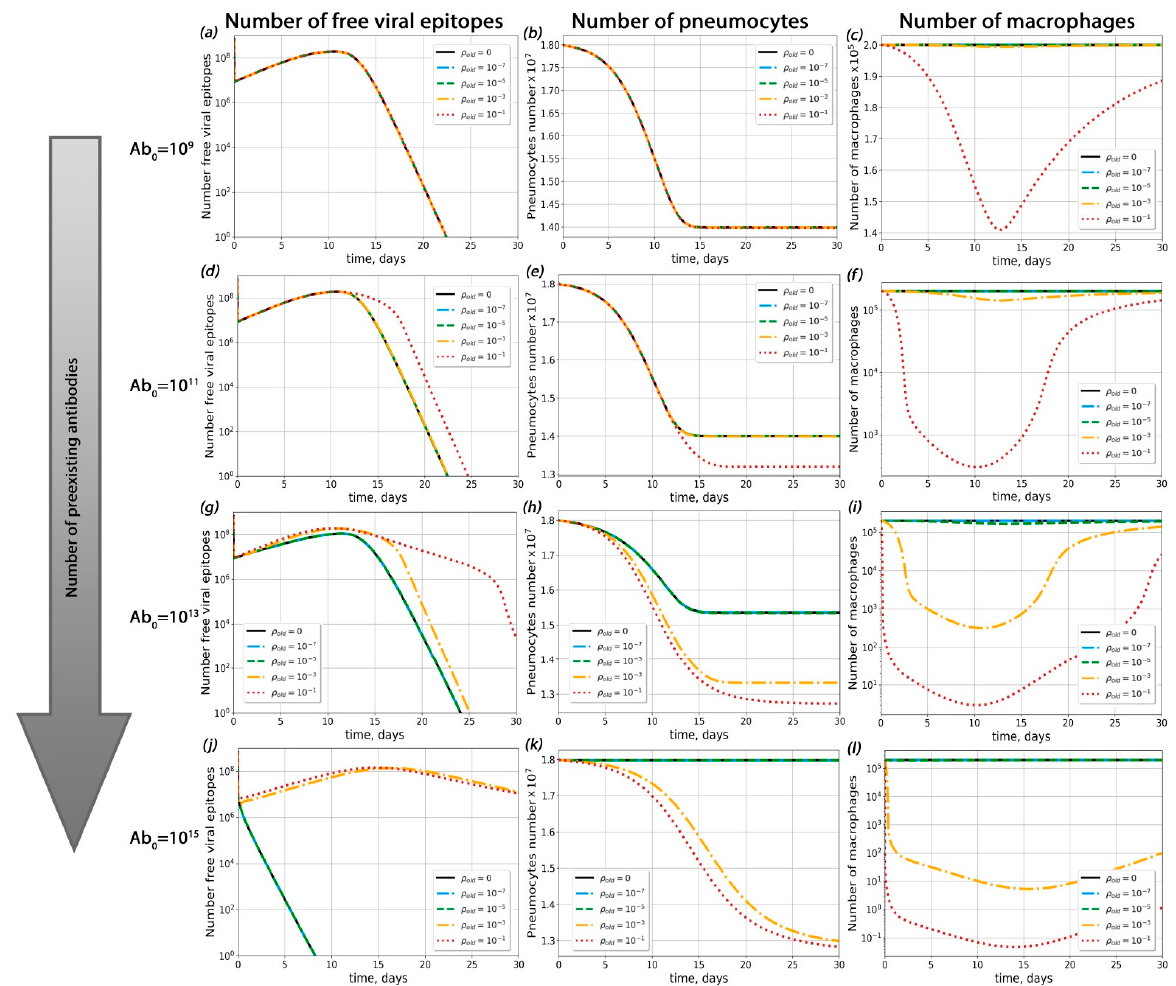
Figure 4. Influence of pre-existing antibodies with different macrophage infection probabilities on possible ADE occurrence. ( a – c ) Viral load dynamics ( a ), pneumocyte number ( b ) and macrophage kinetics ( c ) with different macrophage infection probabilities ( Ab old = 10 9 ). ( d – f ) Viral load dynamics ( d ), pneumocyte number ( e ) and macrophage kinetics ( f ) with different macrophage infection probabilities ( Ab old = 10 11 ). ( g – i ) Viral load dynamics ( g ), pneumocyte number ( h ) and macrophage kinetics ( i ) with different macrophage infection probabilities ( Ab old = 10 13 ). ( j – l ) Viral load dynamics ( j ), pneumocyte number ( k ) and macrophage kinetics ( l ) with different macrophage infection probabilities ( Ab old = 10 15 ).